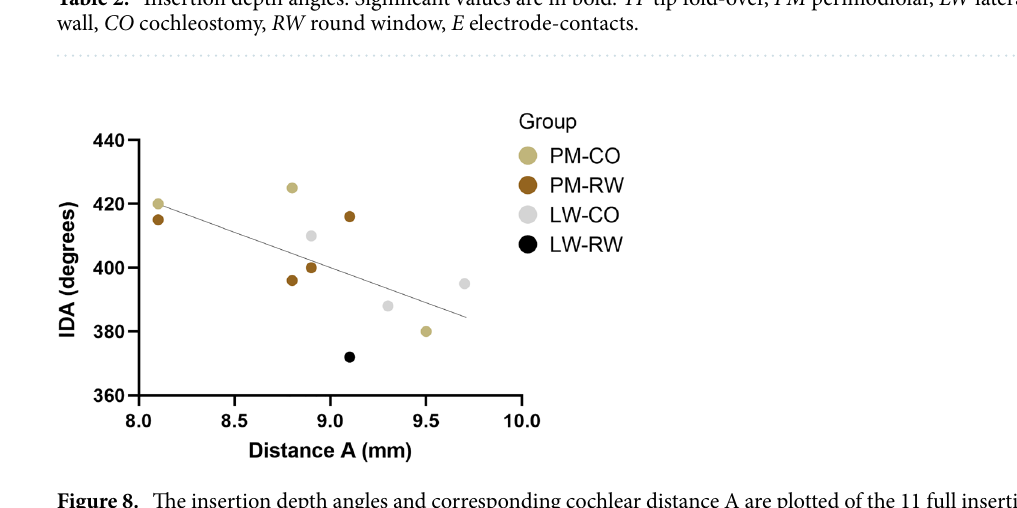
Figure 8. The insertion depth angles and corresponding cochlear distance A are plotted of the 11 full insertions according to the manufactures guidelines. An inverse correlation is observed between insertion depth angle and distance A (R 2 = 0.39, p < 0.05). Distance A is an indirect measure of cochlear duct length. IDA insertion depth angle, PM perimodiolar LW lateral wall, CO cochleostomy, RW round